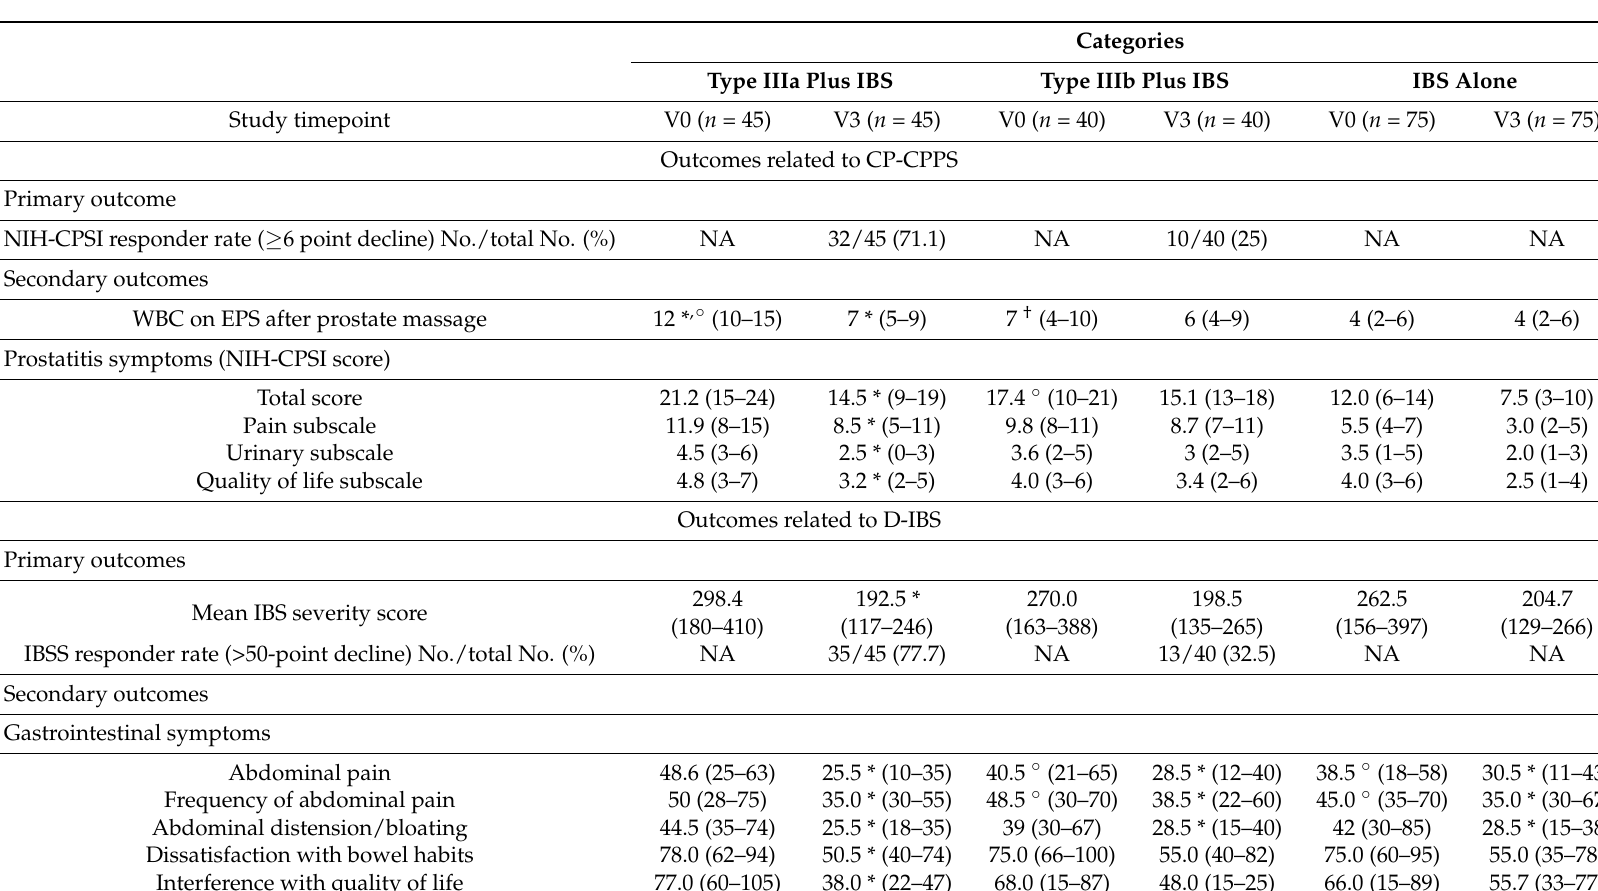
Table 2. Intragroup and intergroup analysis of National Institute of Health Chronic Prostatitis Symptom Index NIH-CPSI score and gastrointestinal symptoms in patients with chronic prostatitis (Type IIIa or IIIb plus IBS, or with IBS alone assessed before the treatment (V0) and three months afterward